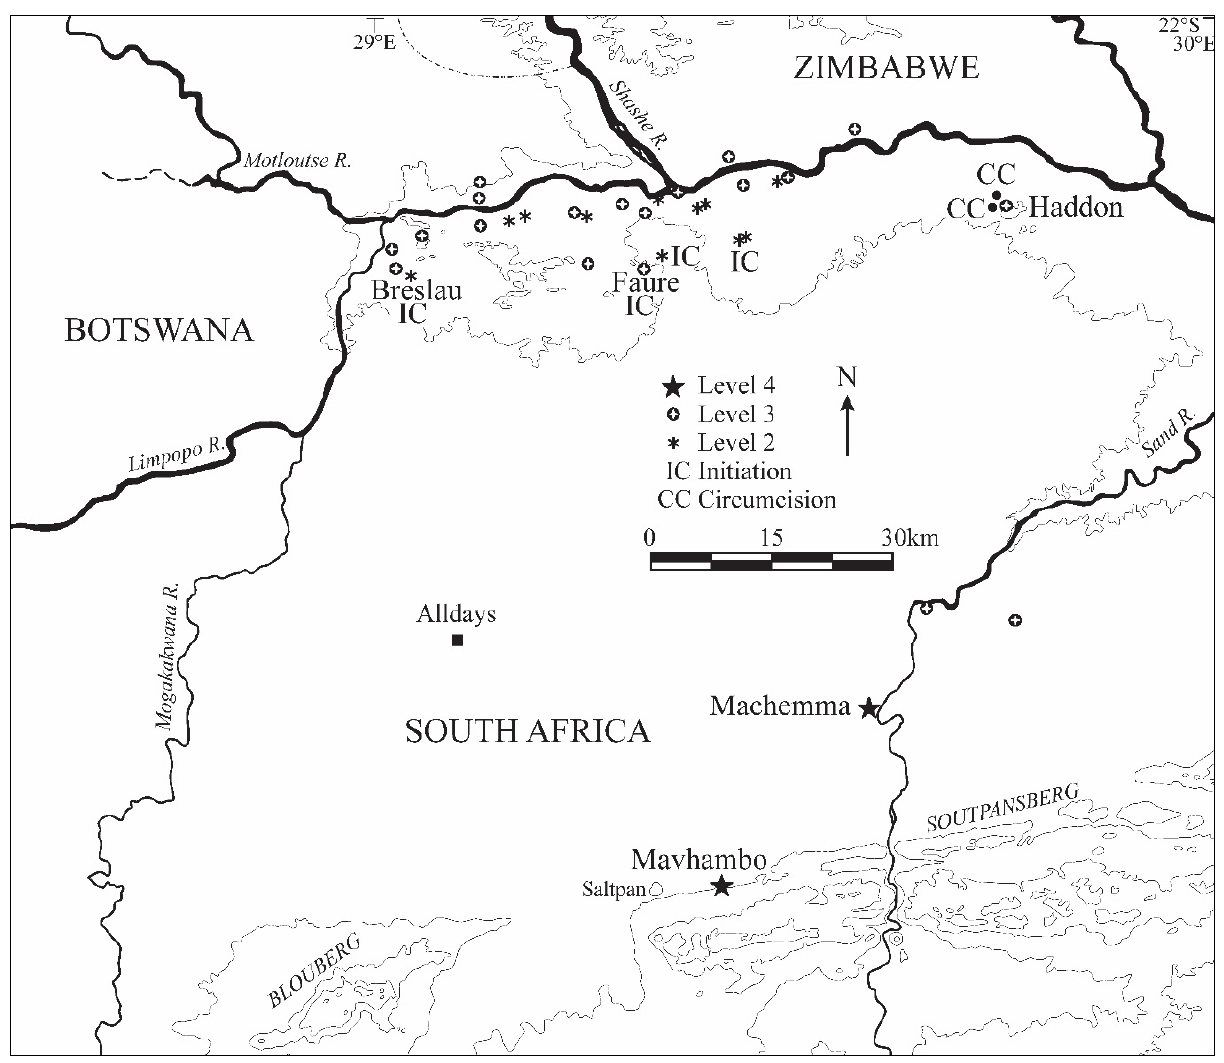
Figure 3: Location of Machemma and Mavhambo in relation to the Limpopo